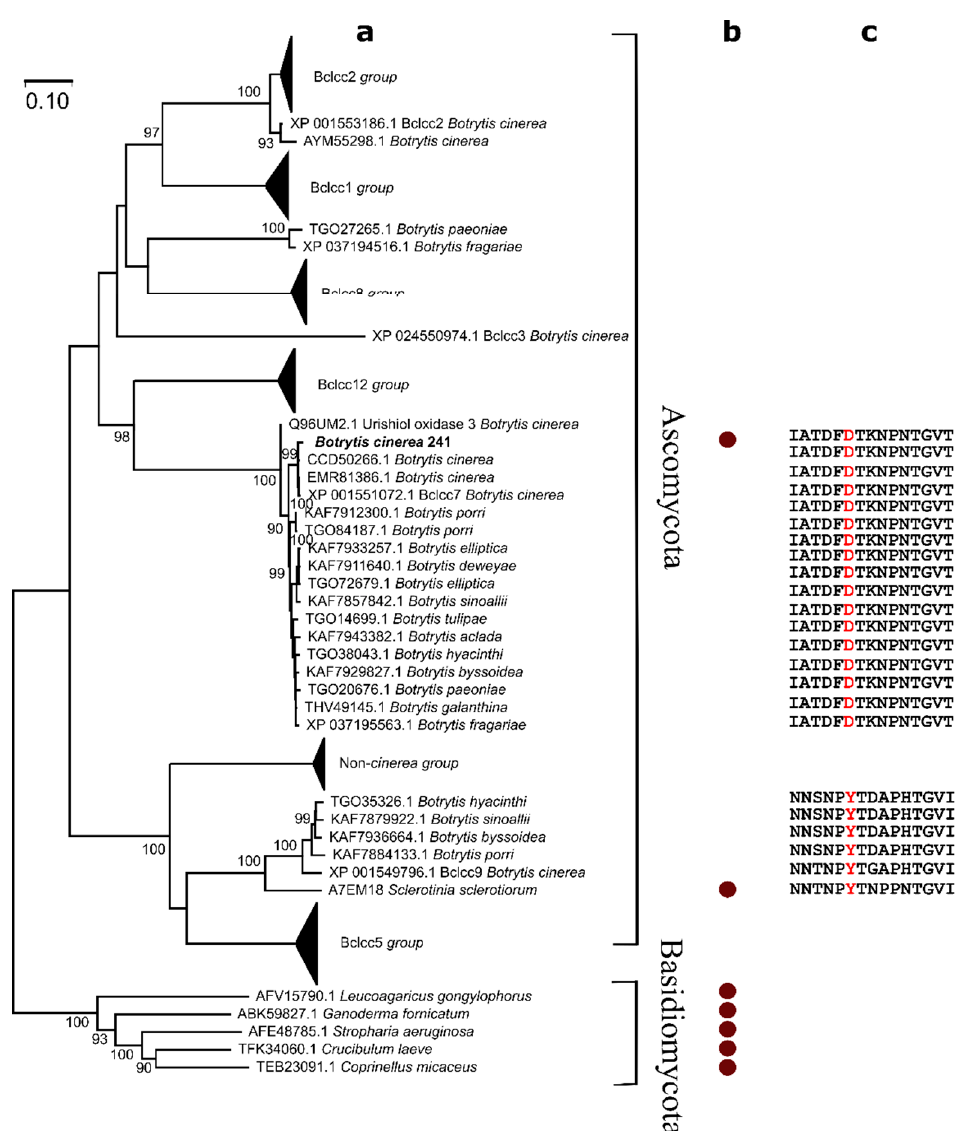
Figure 3. ( a ) The phylogenetic analysis of laccases encoded by Botrytis spp. The evolutionary history was inferred using the Neighbor-Joining method [60]. Scale bar: 10 substitutions site − 1 . The phylogenetic analysis was performed using MEGA X [51]. Bclcc numeration is based on laccases from Botrytis cinerea strain B05.10 (accession number NCBI XP_001551072.1). A yellow laccase from Botrytis cinerea 241 is marked by a bold text. The sequences used for phylogenetic analysis are listed in Table S2. ( b ) Known yellow laccases are included in the analysis, and are marked by circle, respectively. ( c ) Amino acid sequences of a flexible loop, which is homologous to the Sclerotinia sclerotiorum laccase motif containing Y65, that is involved in binding of phenolic compounds. Y65 and the corresponding amino acid residue D132 in Bcl1 are highlighted in red.